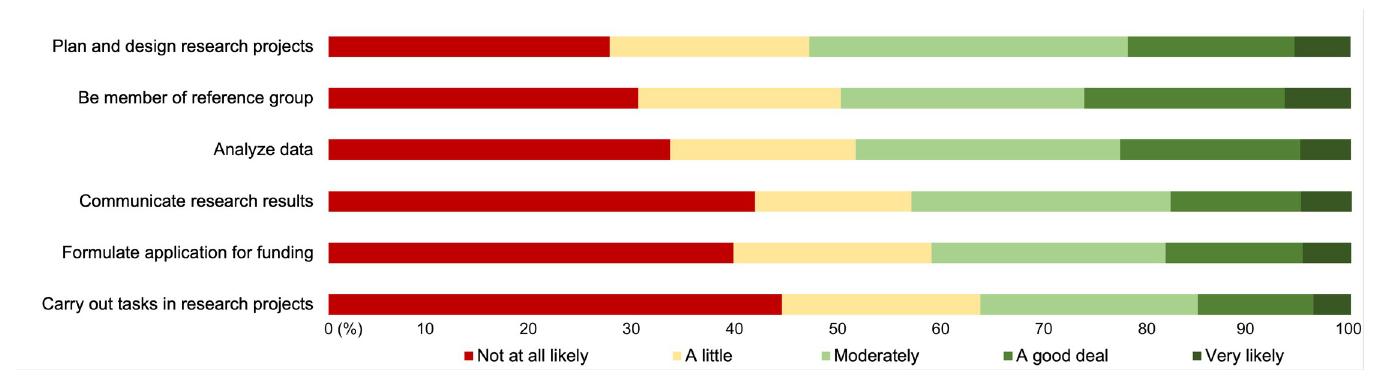
Fig 2. Willingness to be actively involved in research on ageing and health through various